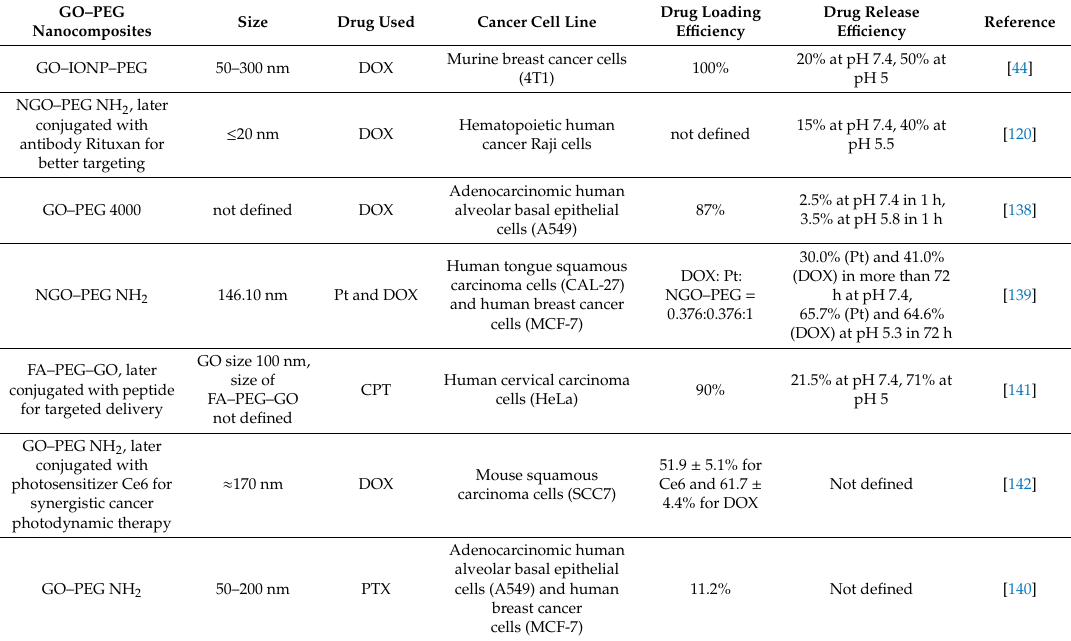
Table 2. Graphene oxide (GO)–polyethylene glycol (PEG) composites, the drug used, type of cancer cell treated, drug loading, and release e ffi